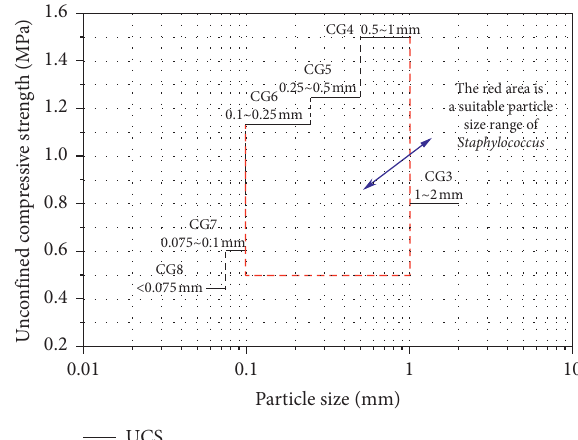
Figure 10: Unconfined compression strength (UCS) of different control group (CG).